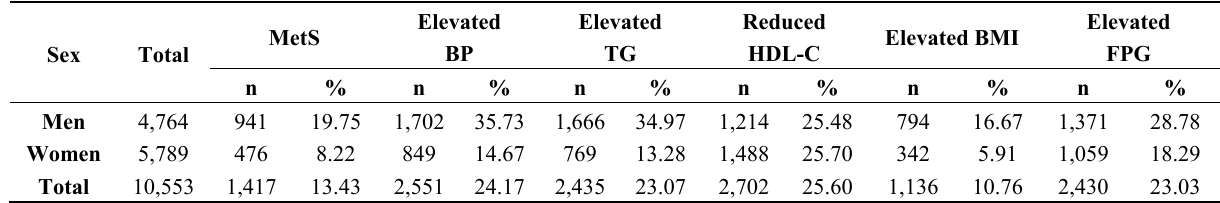
Table 1. Prevalence of MetS and its components by gender.